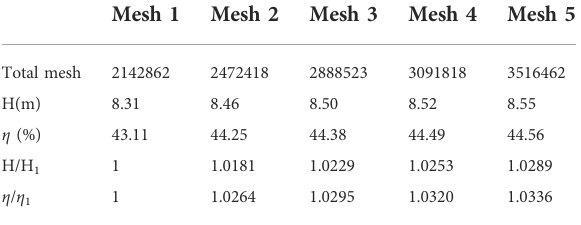
TABLE 2 Grid independence veri fi